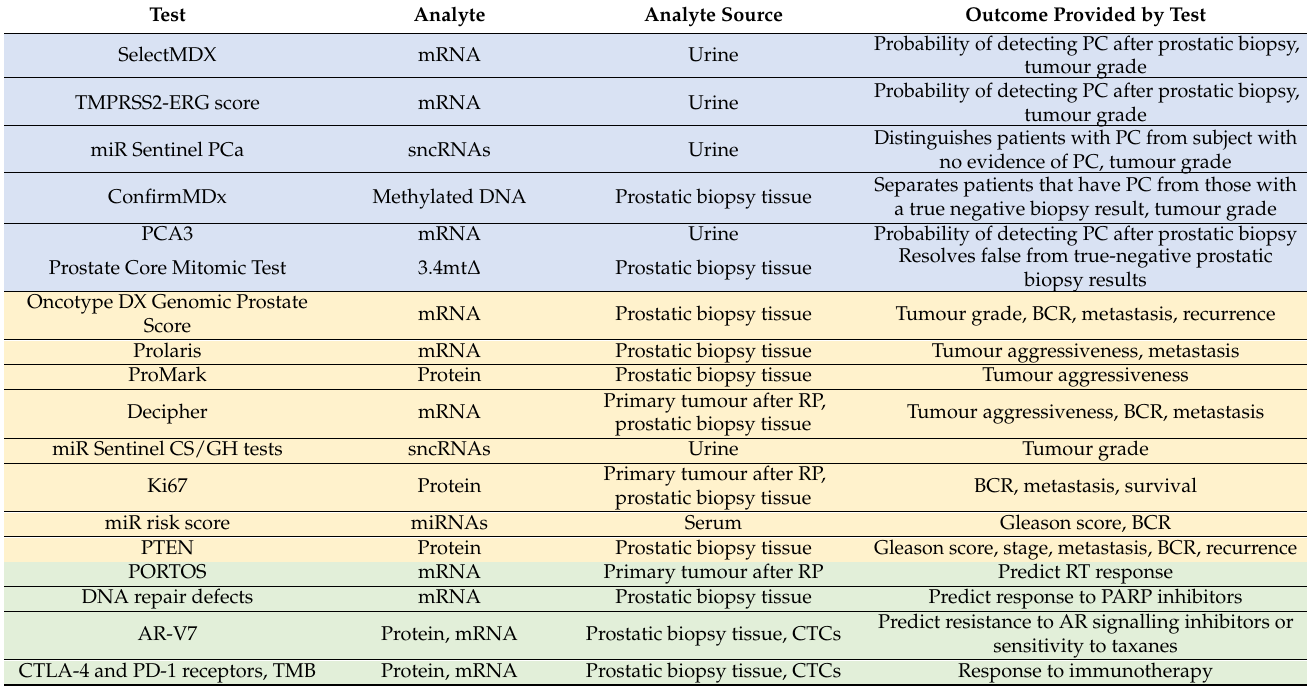
Table 1. Overview of prostate cancer biomarker assays that are in development or have gained clinical approval. Pre- diagnostic biomarkers (blue), biomarkers used in biopsy-proven prostate cancer cases (yellow), predictive biomarkers (green). 3.4mt ∆ , 3.4-kb mitochondrial genome deletion; AR, androgen receptor; AR-V7, androgen receptor splice variant 7; BCR, biochemical recurrence; CTCs, circulating tumour cells; CTLA-4, cytotoxic T lymphocyte-associated protein-4; miRNA, microRNAs; PARP, poly (ADP-ribose) polymerase; PC, prostate cancer; PD-1, programmed death-1; PORTOS, Post-Operative Radiation Therapy Outcomes Score; PTEN, phosphatase and tensin homolog; RP, radical prostatectomy;